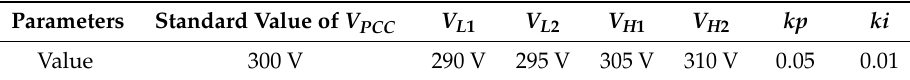
Table 2. Specific settings in parameters.